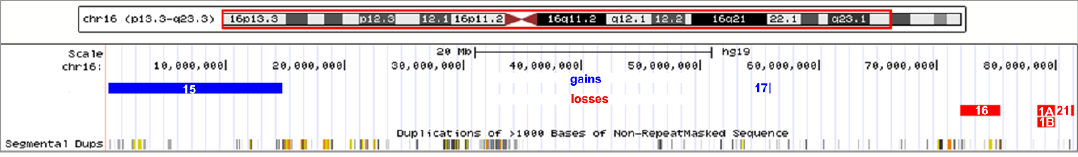
Figure 5. Atypical rearrangements of chromosome 16 associated to clinical signs. One bar corresponds to one patient and the number refers to the patients reported in Table 1. Red bar indicates a deletion, blue bar a duplication. Segmental duplications are reported.